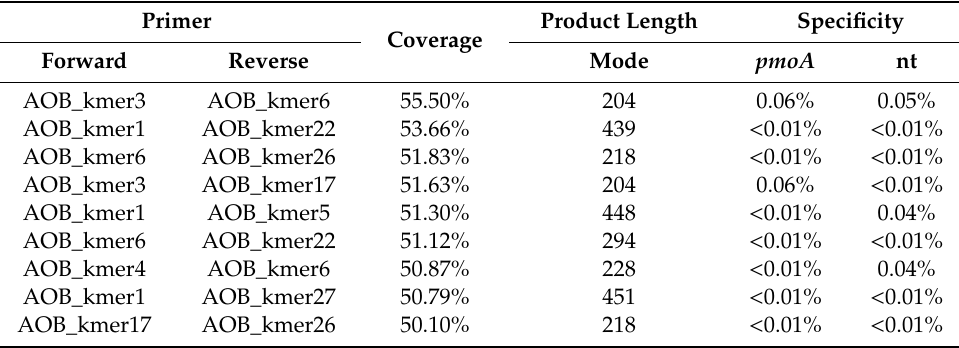
Table 3. Recommended primer sets for amoA gene of